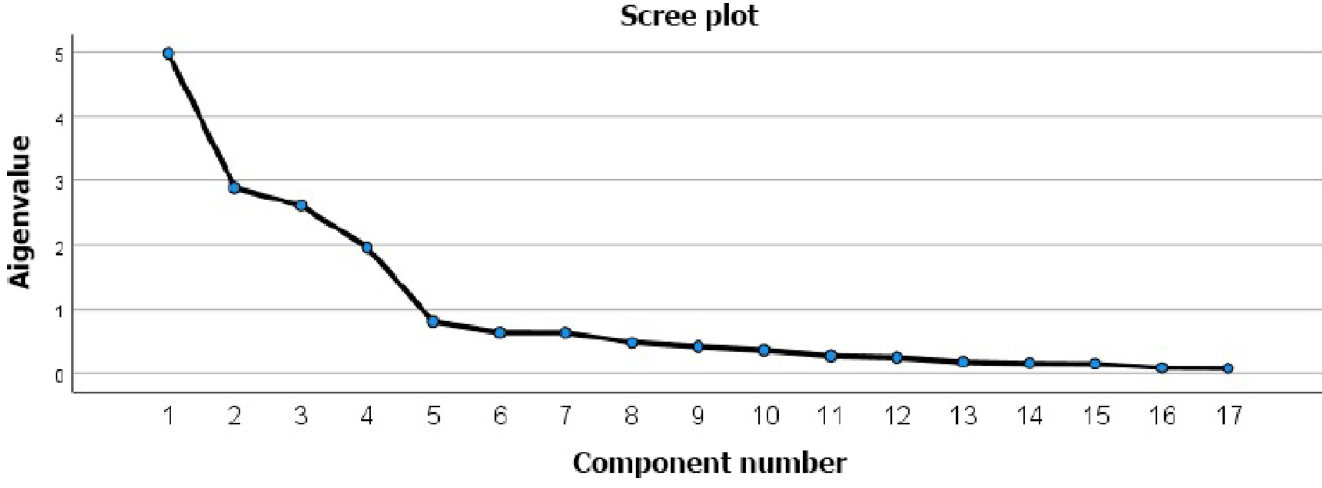
Fig 4. Scree plot of the